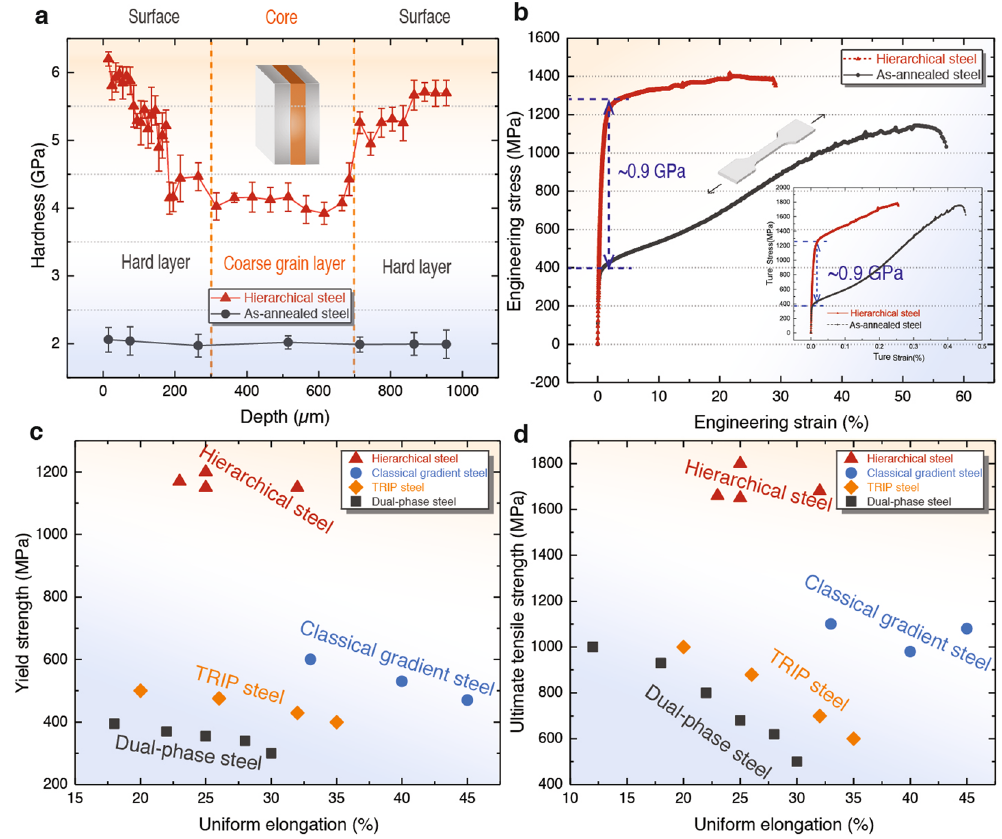
Figure 4. Comparison of mechanical properties of the hierarchical steel with those of other steels. ( a ) Hardness distribution along the cross-section of an as-annealed steel, as compared to our hierarchical steel. Results indicate that the hierarchical steel (red scattering) attains larger improvements in hardness as compared to as-annealed steels. ( b ) Uniaxial tensile tests show engineering stress–strain curves of the hierarchical steel (in red triangle scattering), as compared with that of as-annealed steel; inset graphs show the corresponding true stress-strain curves. Representative tensile properties of steels are shown in ( c ) and ( d ). The data are for dual- phase steels, TRIP-steels, classical gradient steels and our hierarchical steel (this work). Red triangle data points represent the tensile properties of the hierarchical steel. A comparison of the respective yield ( c ) and ultimate tensile strengths ( d ) of dual-phase steels, TRIP-steels, classical gradient steels and hierarchical steels, indicates that the hierarchical steels have a far superior combination of strength and ductility in comparison to other steels.